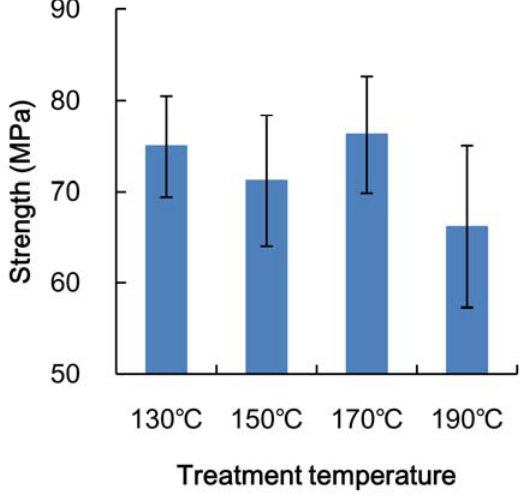
Figure 3. Strength of heated poplar veneer in bending test.